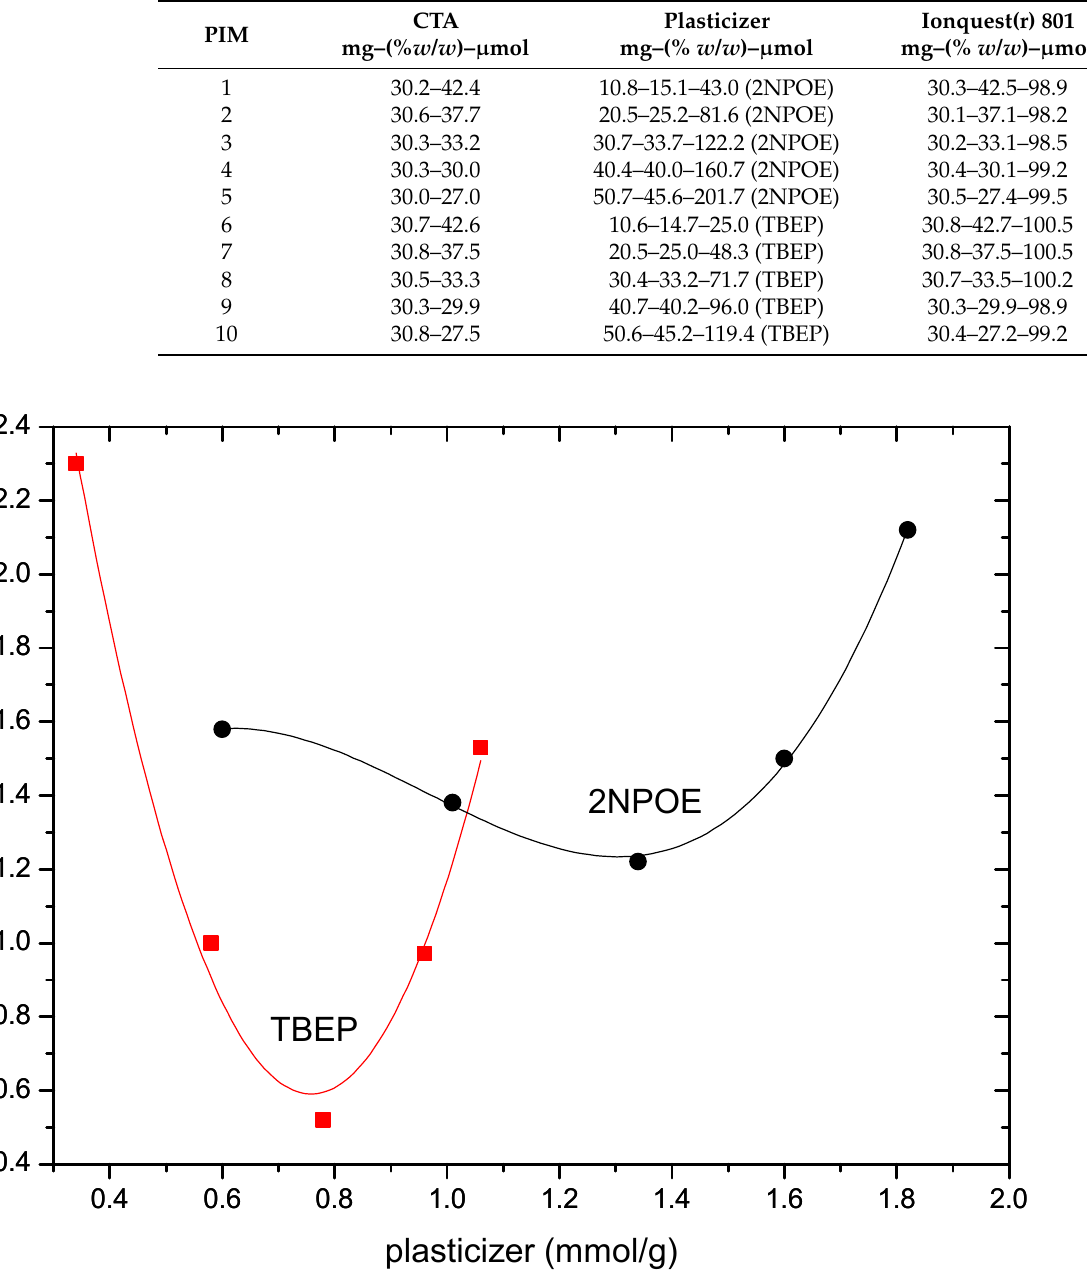
Table 4. PIM compositions to study In (III) permeability profiles as a function of plasticizer content.